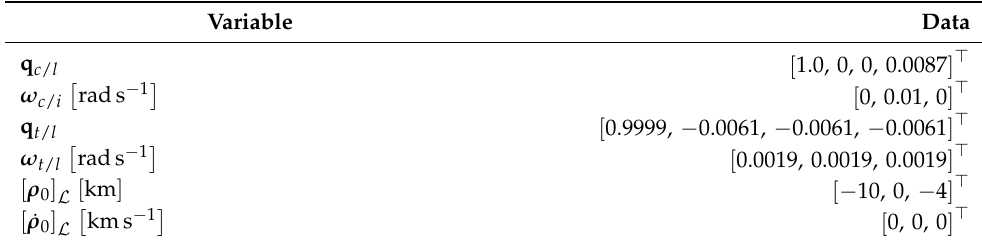
Table 6. Initial attitude